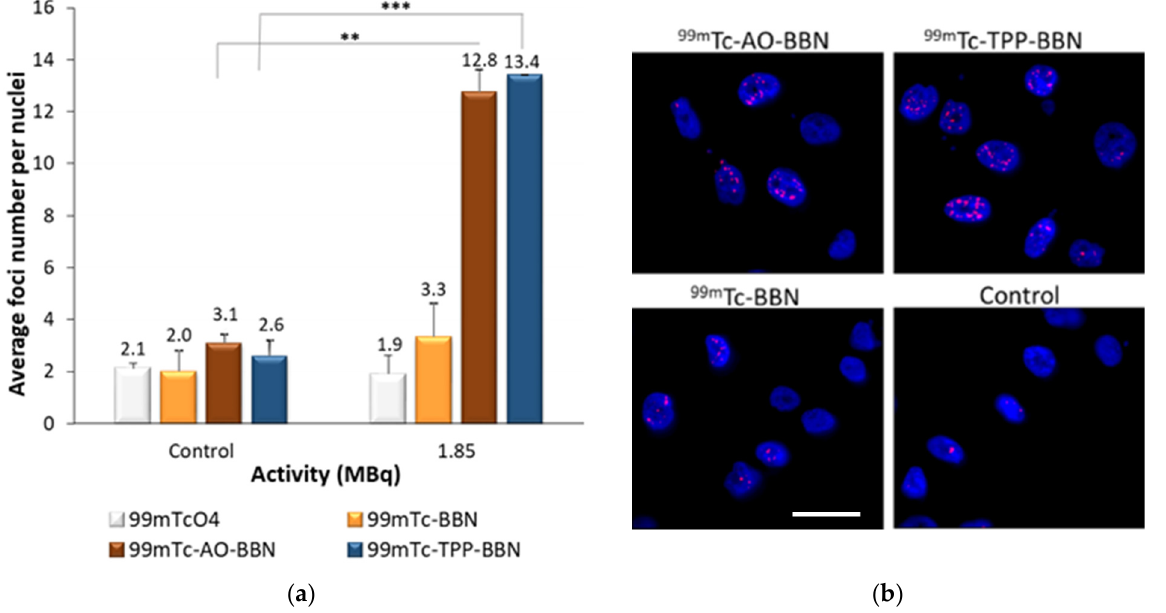
Figure 7. DNA damage induced by HPLC-purified 99m Tc-BBN , 99m Tc-AO-BBN and 99m Tc-TPP-BBN and 99m TcO 4 (1.85 MBq) in PC3 cells after 24 h of incubation at 37 °C. ( a ) The average number of foci per nuclei in PC3 cells, the data corresponding to the mean ± SEM of 3 replicates (** p < 0.01 and *** p < 0.005). ( b ) Fluorescence images of PC3 cells exposed to 1.85 MBq of 99m Tc complexes. Cells were immunostained for γ -H2AX, and DAPI was used to visualize the nuclei. Scale bar = 50 µ